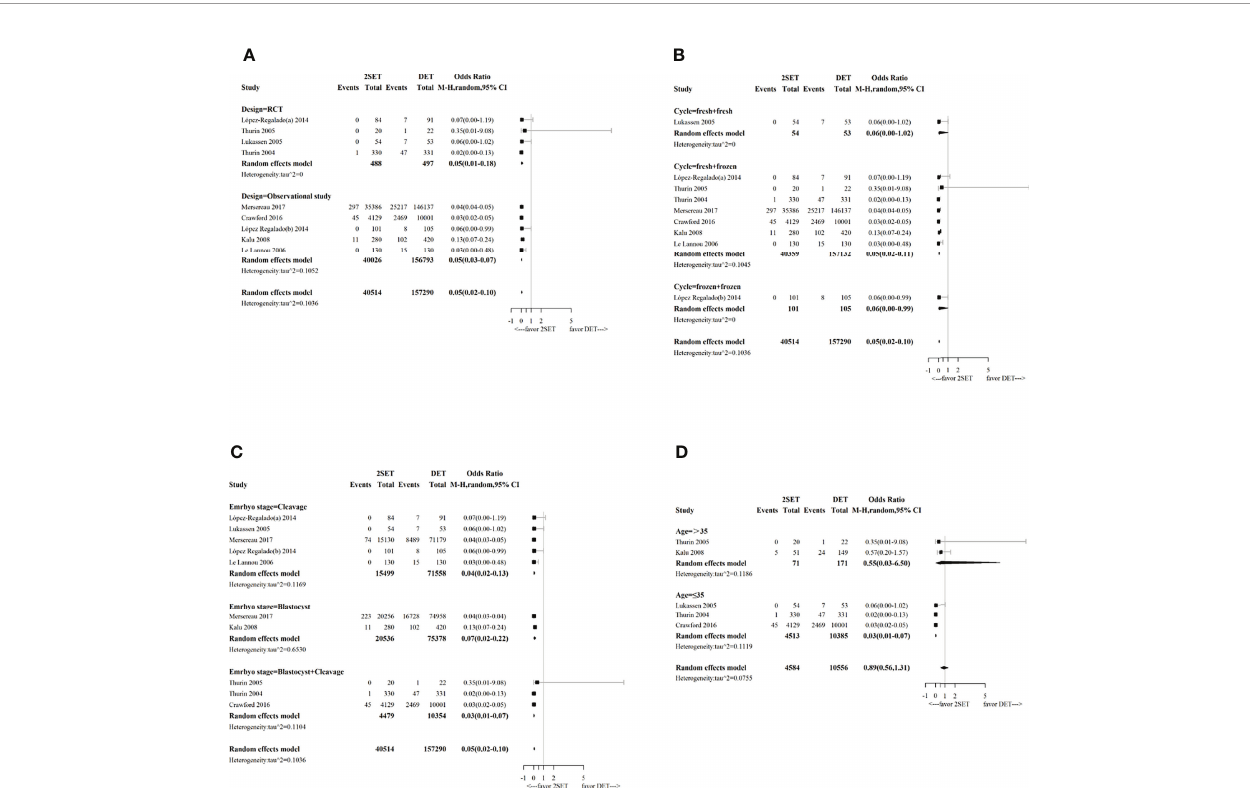
FIGURE 5 | Forest-plot with subgroup analysis comparing cumulative multiple live birth rate after two consecutive cycle of single embryo transfer (2SETs) and one cycle of double embryo transfer (DET) based on: (A) study design, (B) cycle type, (C) embryo stage and (D) maternal age strati fi